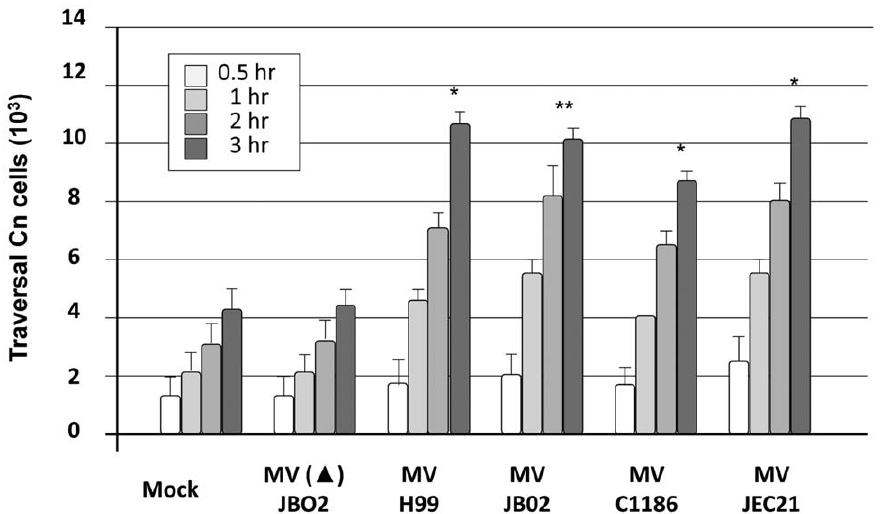
Figure 2. Effect of CnMVs on the traversal of C.neoformans cells through an HBMEC layer invitro . CnMVs were isolated from different strains, as indicated on the bottom of the figure. In vitro transcytosis assays were performed using strain B-4500FO2 (10 6 cells) and 10 m g purified CnMVs. No MV treatment (Mock) and treatment with heat-inactivated MVs (MV m ) from the JB02 strain were used as controls. Each group contained four bars representing the 0.5, 1, 2, and 3 hour time points. Triplicate samples at each time point were analyzed. CFUs were determined from the cultures in the lower chambers of the transwells, and the recovery percentage was determined at indicated time points (n=3). Analysis of variance showed a significant difference between the CnMV-treated samples and the controls (mock or heat-inactivated MV) as indicated by asterisks (*P , 0.05; **P , 0.01). doi:10.1371/journal.pone.0048570.g002 contrast, CnMVs had little effect on the distribution of vimentin results suggested that CnMVs can activate surface membrane of (Fig. 4B, last panel). Since CD44, caveolin-1, and b -actin are HBMECs and facilitate C. neoformans adhesion (Fig. 5) and involved in cell-cell interaction, cell adhesion, or migration, these transcytosis (Fig. 2).